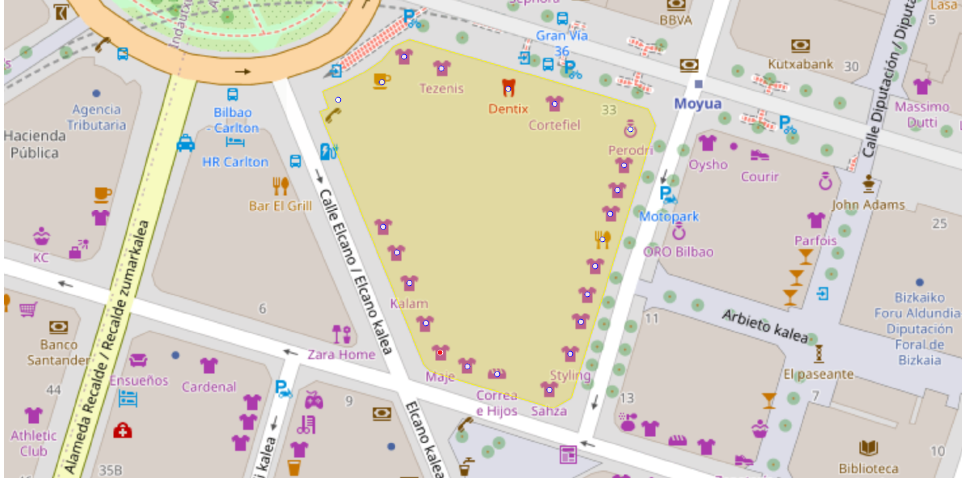
Figure 15. The target shop and its